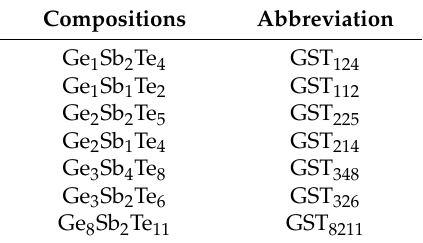
Table 1. Various compositions of the germanium-antimony-telluride (GST) material with an abbreviation.